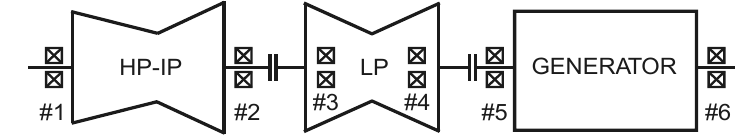
Fig. 1. Machine-train diagram and support numbers.